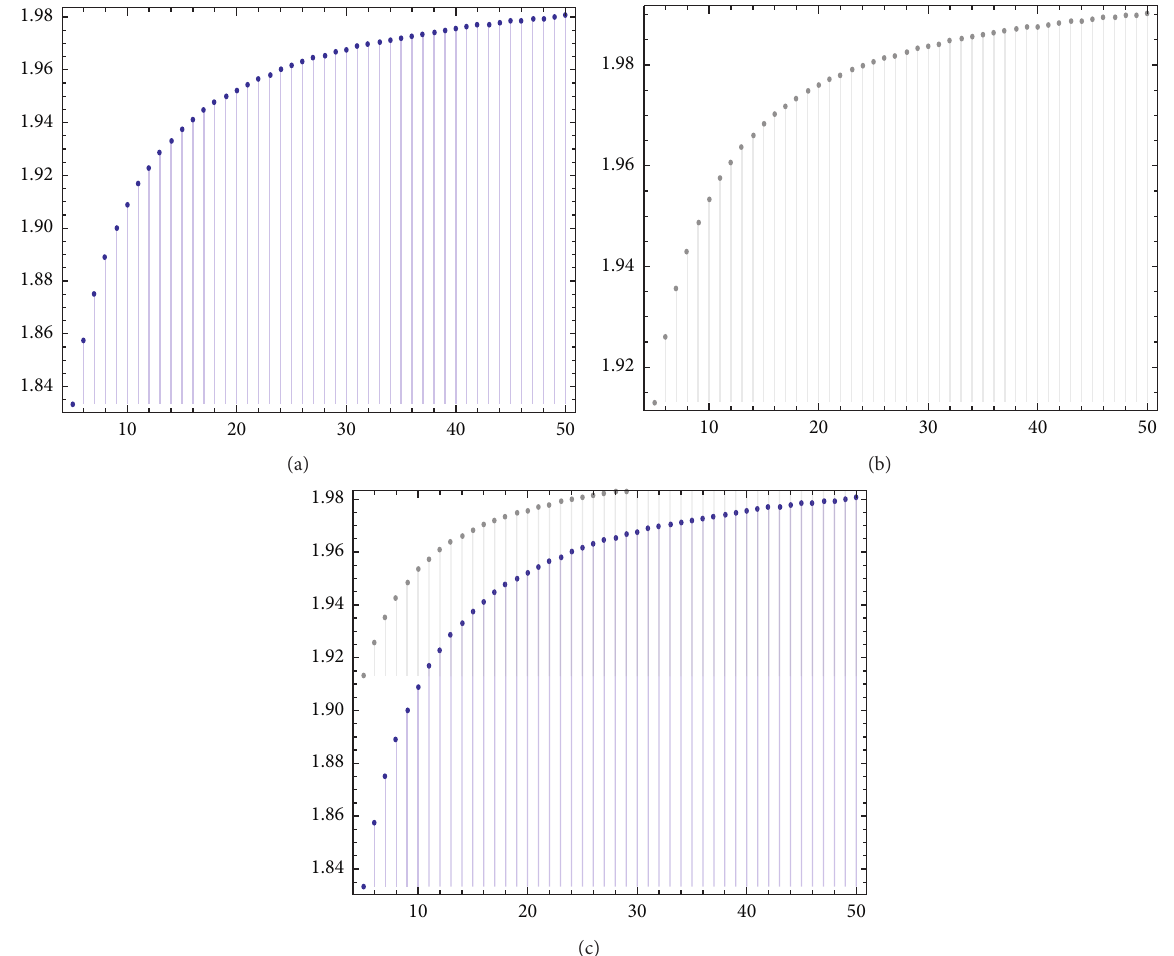
Figure 8: Graph of sequences of rotationally symmetric hexagonal planar networks H i